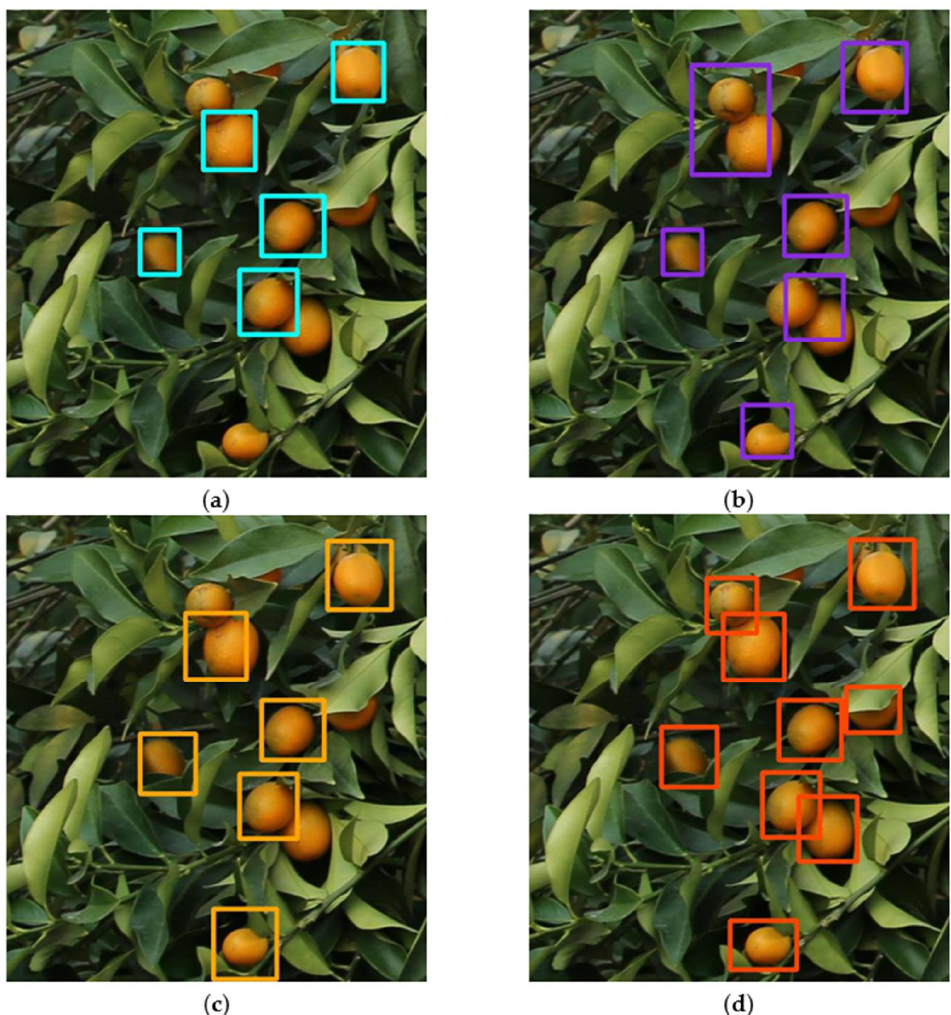
Figure 11. The detection results of tangerine in the mature stage: ( a ) Faster R-CNN; ( b ) YOLOv4; ( c ) YOLOv5l; ( d ) improved YOLOv5. Table 5. The comparison results of four object models on the tangerine dataset at two growth stages.